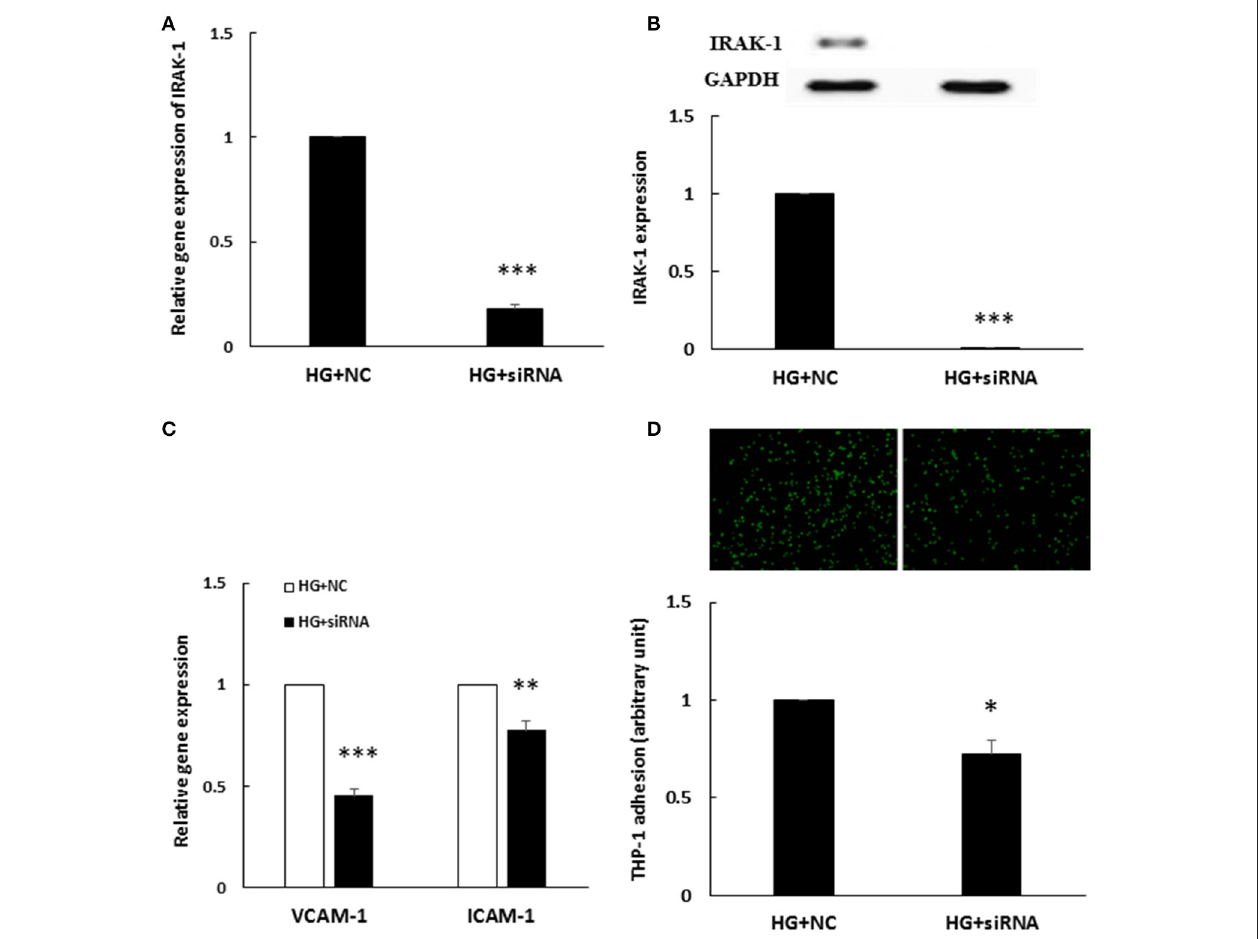
FIGURE 4 | (A–D) HG-induced endothelial inflammation was reduced by IRAK-1 siRNA transfection (A) . IRAK-1 gene expression levels were reduced by IRAK-1 siRNA. n = 3. *** p < 0.001, compared with the negative control (NC) ( t -test). (B) . IRAK-1 protein expression levels were reduced by IRAK-1 siRNA. n = 3. *** p < 0.001, compared with the NC ( t -test). (C) The stimulatory effect of HG on VCAM-1/ICAM-1 gene expression was inhibited in IRAK-1 siRNA-transfected HAECs. n = 3, ** p < 0.01 and *** p < 0.001, compared with the NC ( t -test). (D) The stimulatory effect of HG on THP-1 adhesion to HAECs was inhibited in siRNA IRAK-1-transfected HAECs. n = 3. * p < 0.05, compared with the NC ( t